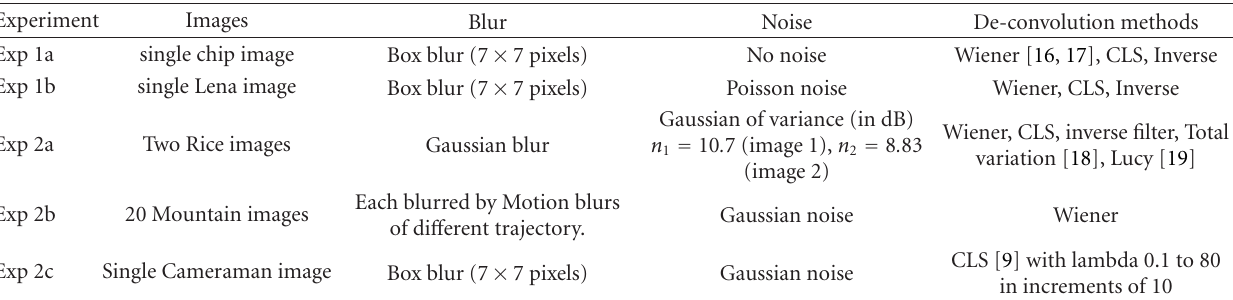
Table 1: Details of the experiments